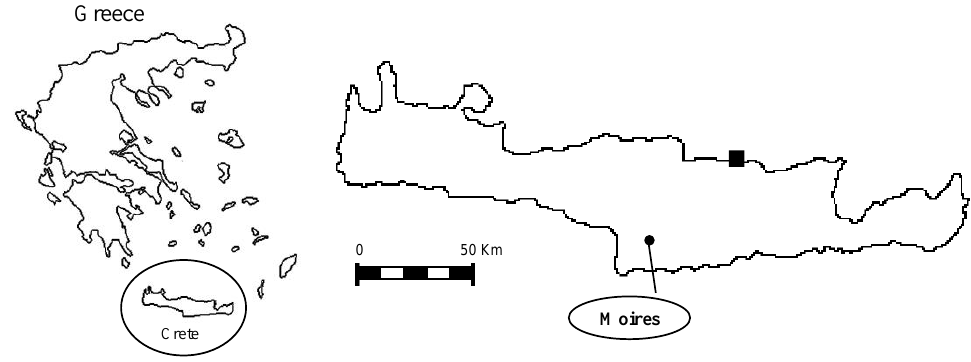
Figure 1. Location of the survey area in Crete, Greece. Table 1. Number of orchards surveyed for fruit and oil yields (orchards sampled for fruit quality parameters and fatty acid composition).